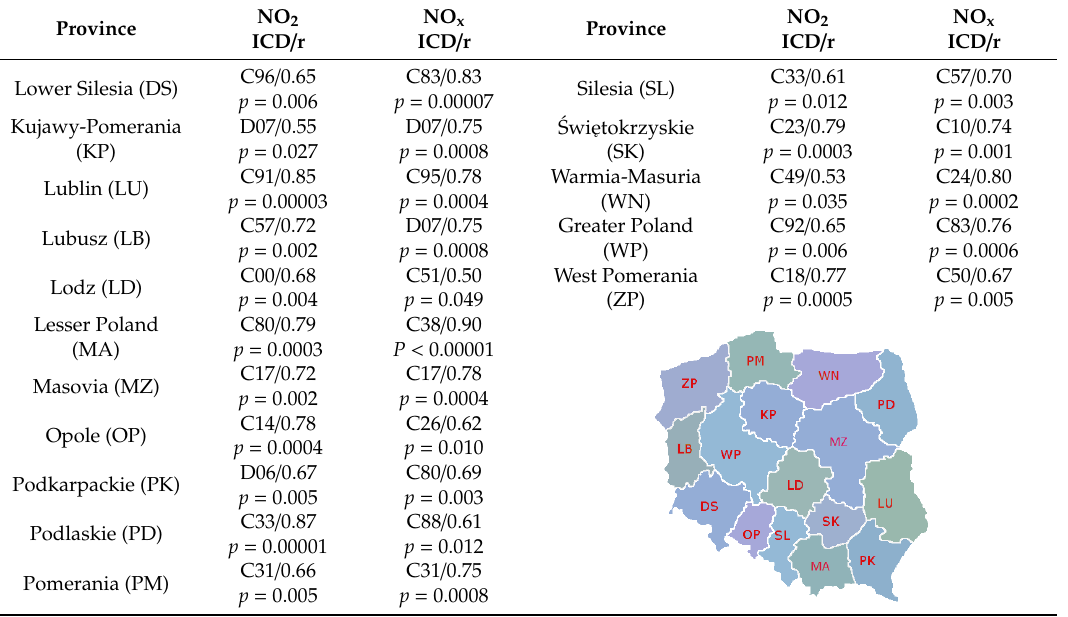
r—Pearson correlation coefficient, ICD—International Classification of Diseases code. The choice of the type of cancer that were examined in detail was guided by the ratio of deaths to malignant neoplasms in Poland in the period available in the database (Figure 4), as well as the trends of the highest increases in